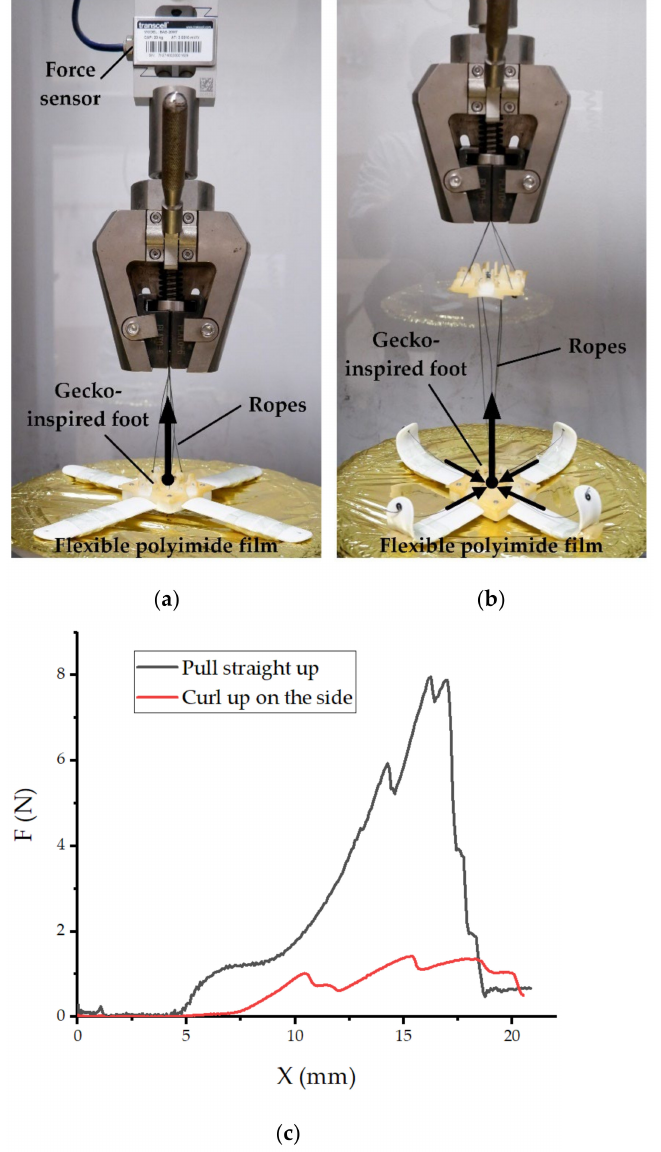
Figure 16. Foot design of the toe pad of gecko feet performance test: ( a ) The toe pad of the foot is desorbed by pulling up; ( b ) the toe pad of the foot is desorbed by rolling up; ( c ) the test